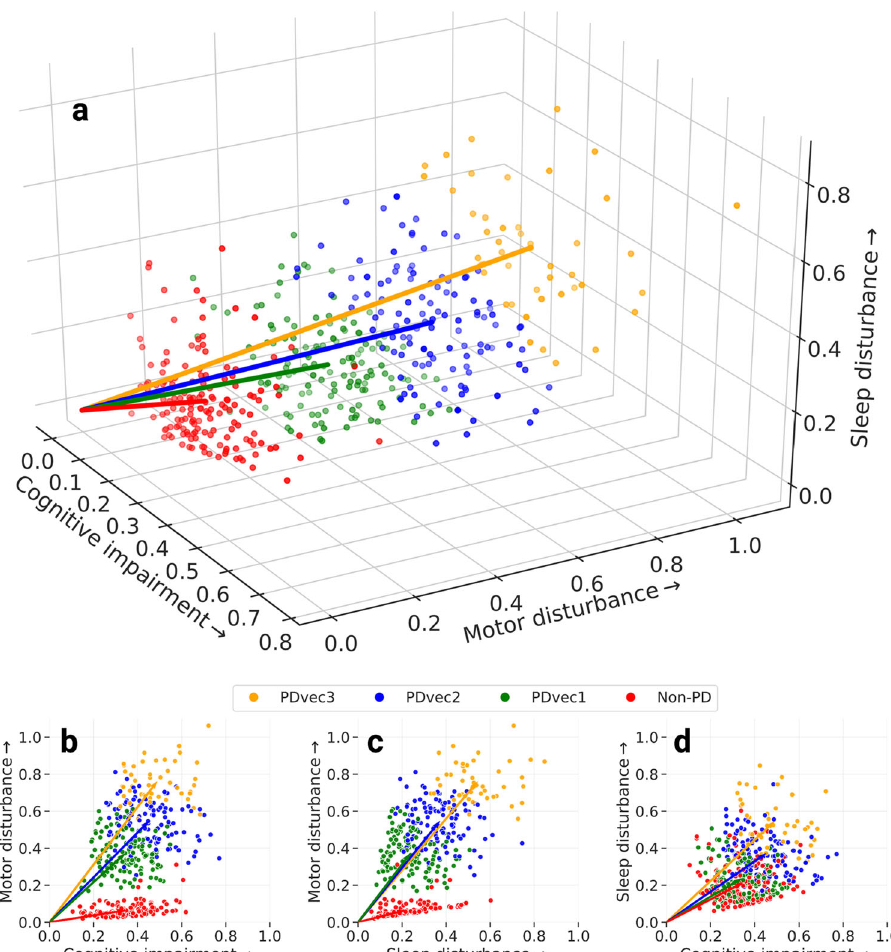
Fig. 2 Different views of the Parkinson ’ s disease progression space in 5 years with three corresponding projected dimensions (cognitive, motor, and sleep dimensions) on a normalized scale. Subtypes of PD are identi fi ed using unsupervised learning (PDvec1, PDvec2, and PDvec3). a Shows the view of all three dimensions, b view of the motor and cognitive dimensions, c view of motor and sleep dimensions, and d view of sleep and motor